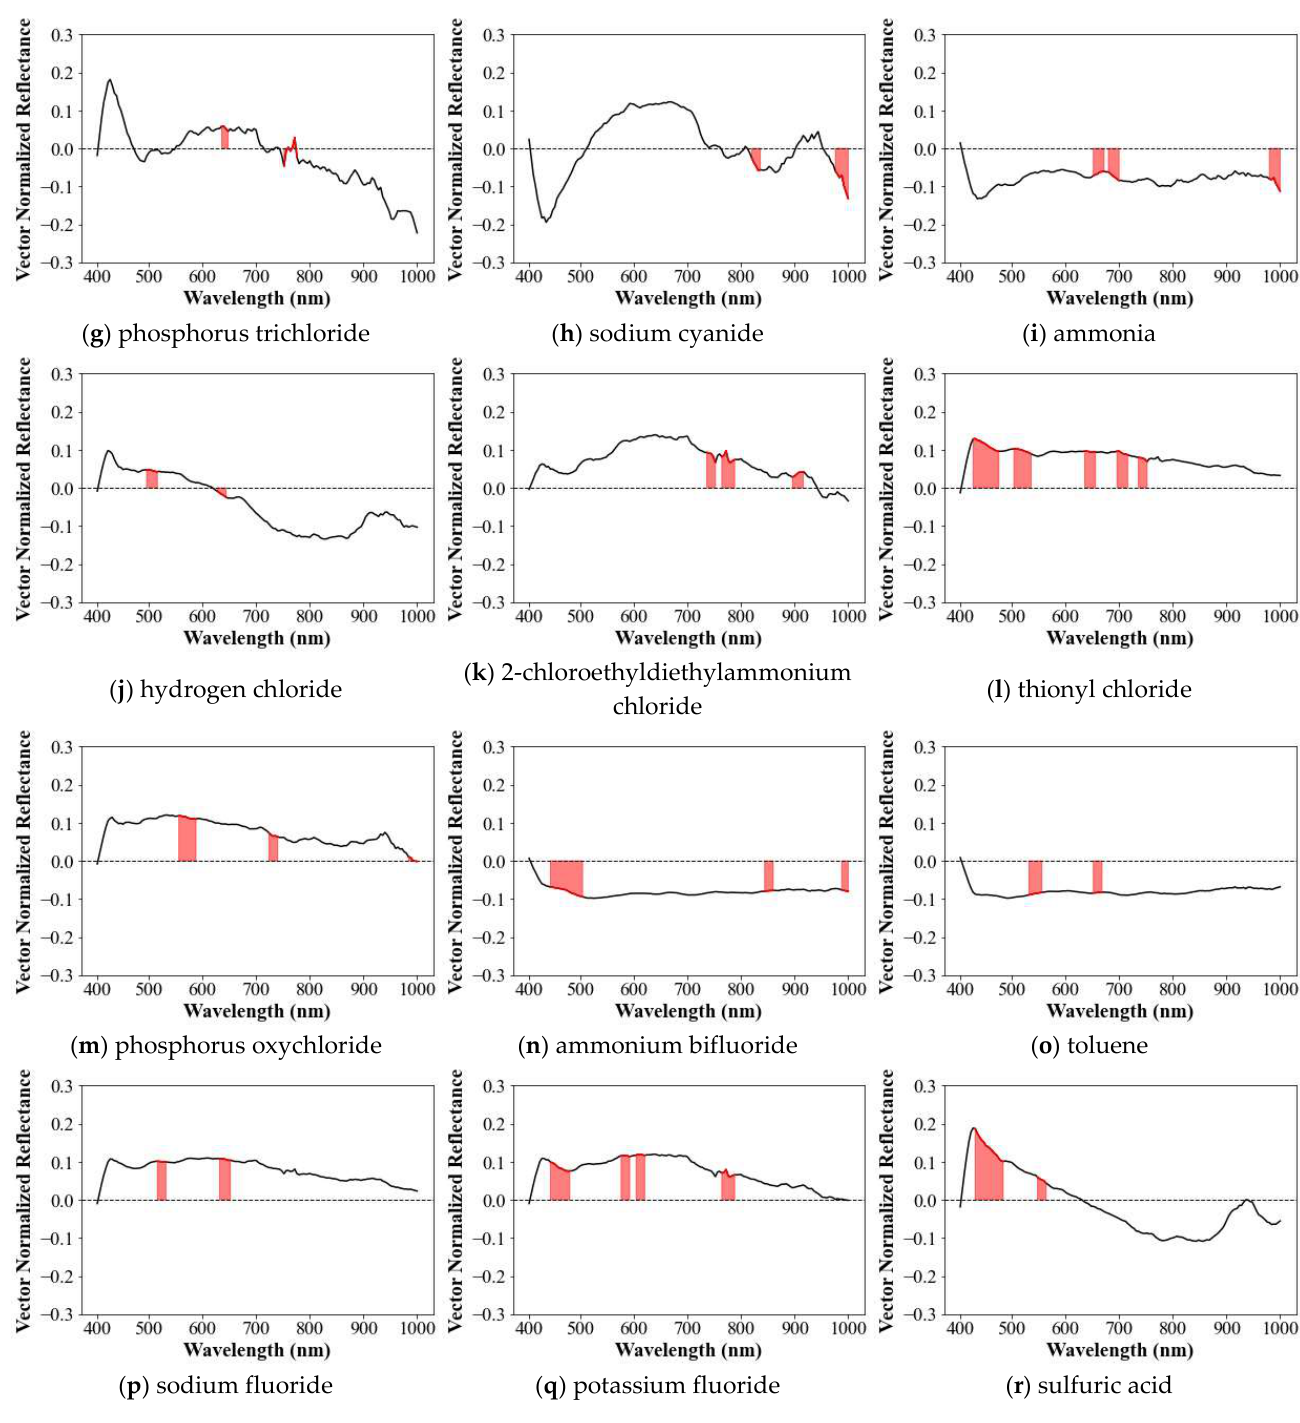
Figure 9. Characteristic spectral library. ( a ) 2-Chloroethanol; ( b ) glycidol; ( c ) methyl ethyl ketone; ( d ) hydrogen fluoride; ( e ) bromine; ( f ) arsenic trichloride; ( g ) phosphorus trichloride; ( h ) sodium cyanide; ( i ) ammonia; ( j ) hydrogen chloride; ( k ) 2-chloroethyldiethylammonium chloride; ( l ) thionyl chloride; ( m ) phosphorus oxychloride; ( n ) ammonium bifluoride; ( o ) toluene; ( p ) sodium fluoride; ( q ) potassium fluoride; ( r ) sulfuric acid.